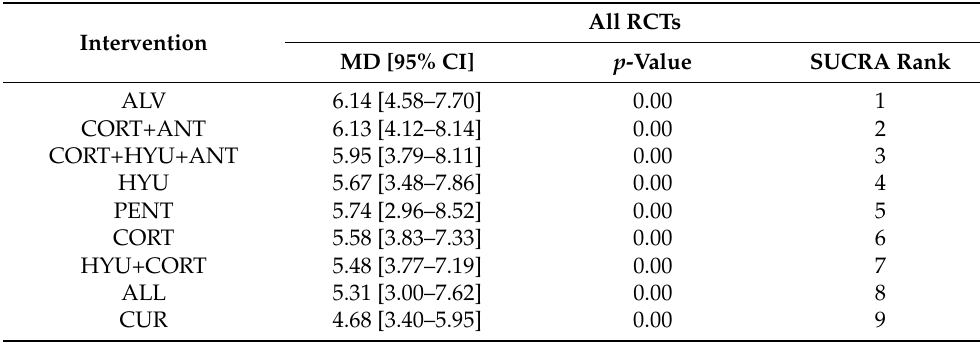
Table 2. SUCRA ranking table for the comparative efficacy of different interventions used in the management of OSMF (burning